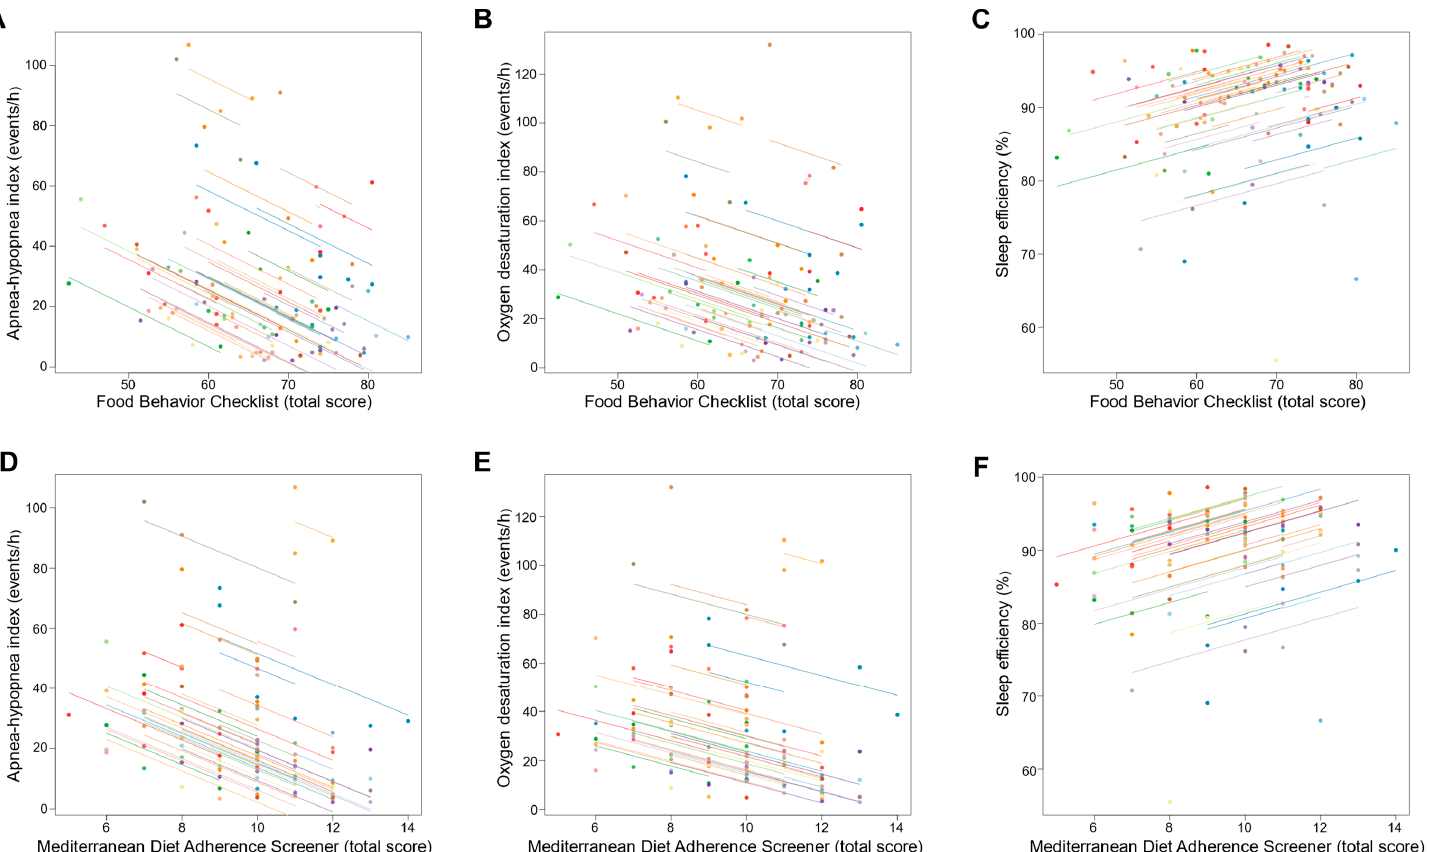
Figure 3. Association of changes in dietary behavior over time with changes in sleep outcomes. Each dot represents one of three separate observations (baseline, 8 weeks and 6 months after intervention) of dietary behavior—as measured by the Food Behavior Checklist ( A – C ) and Mediterranean Diet Adherence Screener ( D – F )—and sleep outcomes for a participant. Observations from the same participant are given the same color, with corresponding lines to show the repeated measures correlation fit for each participant. ( A – C ) The Food Behavior Checklist assesses dietary behavior (range, 23–85; higher scores indicate healthier dietary behavior) [45]. ( D – F ) The Mediterranean Diet Adherence Screener assesses adherence to the Mediterranean diet (range, 0–14; higher scores indicate greater adherence; scores ≥ 10 indicate high adherence to the Mediterranean diet) [46].